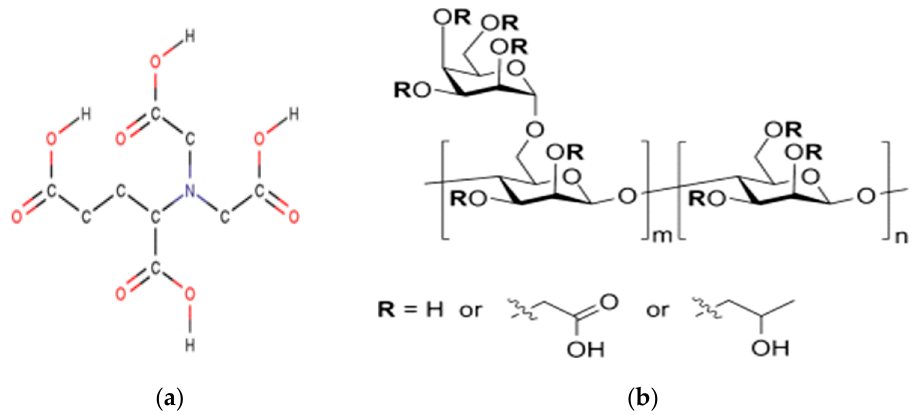
Figure 1. Chemical structure of low pH GLDA ( a ) and chemical structure of CMHPG ( b ). Table 2. Salt composition in synthesized Carboxymethyl hydroxypropyl guar (CMHPG) polymer was used as a gelling agent and supplied by a service provider company. CMHPG is a biopolymer, a guar gum de-